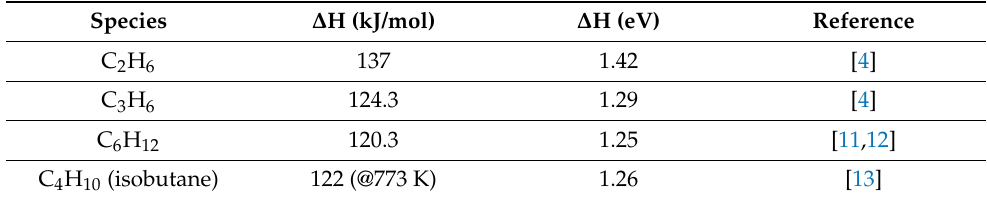
Table 2. Enthalpies of dehydrogenation for selected hydrocarbons (standard enthalpies except where